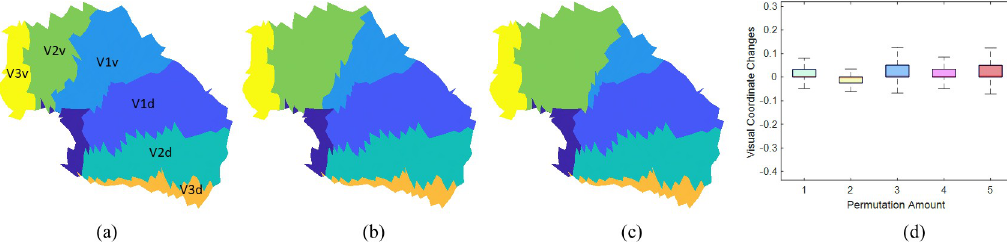
Fig 15. (A, B, C) Perturbations of the V1/V2 boundary, where (B) was obtained after three rounds of expansion and (C) was obtained after five rounds of expansion. (D) Visual coordinate changes with different degrees of perturbations.